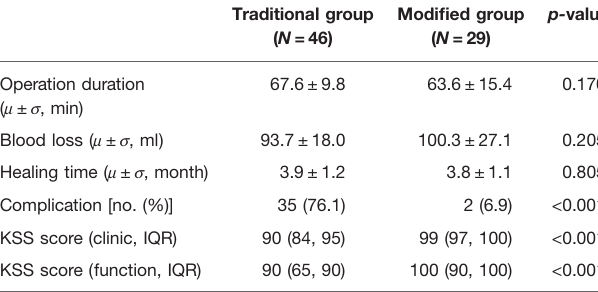
TABLE 2 | The data of operation and outcome.